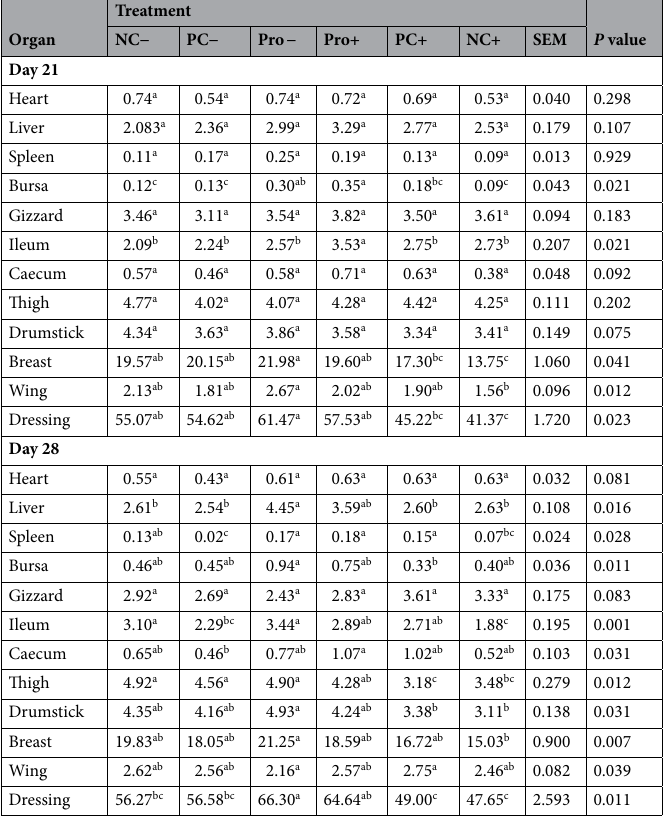
in NC−, glucose levels were significantly(P < 0.05) reduced in the same groups. Similarly, protein levels were significantly (P < 0.05) higher in probiotics supplemented groups when compared with other groups on day 28 (Table 6). The results of the haematogical parameters analyzed are shown in Table 7. Whereas no difference (P > 0.05) was recorded in total RBC, haemoglobin, ESR, PCV, basophiles, monocytes, total platelet count and MPV across the treatments on day 21, statistical difference were recorded for total WBC and neutrophils between the pro- biotics supplemented groups when compared with other treatments. Nevertheless, on day 28 of the experiment MCV and RDW were significantly (P > 0.05) higher in probiotics supplemented groups Pro– and Pro+ when compared with non- P. multocida challenged negative control group, NC−. Also, probiotics supplemented birds with or without P. multocida challenge significantly (P < 0.05) increased total WBC counts at the end of the trial. Also, the concentrations of lymphocytes and monocytes were higher in probiotics supplemented groups while PC− and Prob− had higher (P > 0.05) total platelet counts on day 28 of the experiment. Anti‑inflammatory gene expression. On 14-day post P. multocida challenged, dietary supplementa- tion of birds with probiotics significantly (P < 0.05) upregulated the mRNA profiles of anti-inflammatory genes including HIF1A (hypoxia inducible factor 1 alpha) and TSG-6 (Tumor necrosis factor- (TNF) stimulated gene- 6) on the caecal mucosa when compared to the birds in the control group (Table 8). However, when both anti- inflammatory genes are compared, probiotic effect in the upregulating the expression of HIF1A was higher than for PTGER2. There was no difference in the expression of both anti-inflammatory genes in birds supplemented with antibiotic and the negative control except for TSG-6 (Table 8).